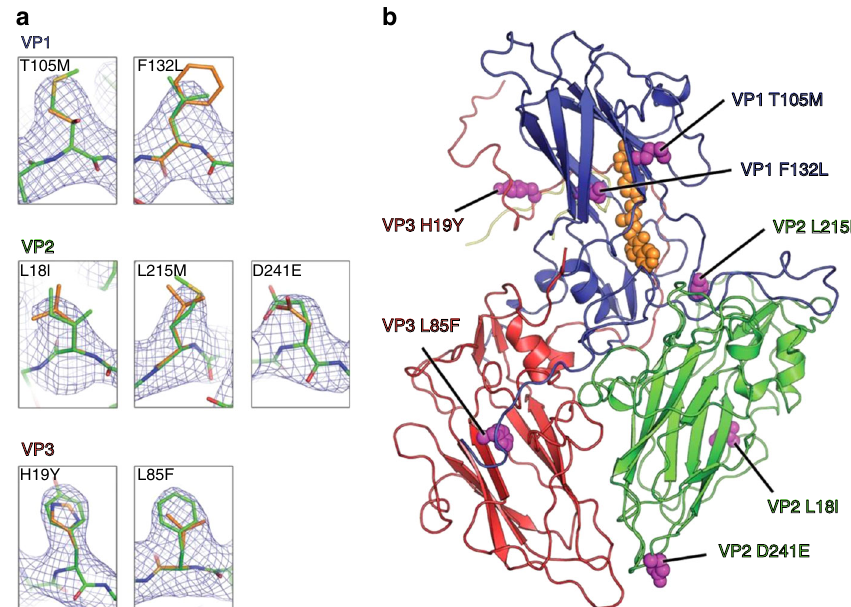
Fig. 4 Stabilizing mutations in PV3 sVLPs. a Mutations in the PV3 SktSC8 sVLP compared to wt sequence. Panels show a snapshot of cryo-EM density for each of the mutations present in the PV3 SktSC8 sVLP. Wt residues are shown as sticks colored orange , with mutated residues observed in the 3.6 Å cryo- EM map as green . Cryo-EM density maps are contoured at 1.0 σ . b Cartoon representation of the asymmetric unit for the PV3 SktSC8 sVLP. Individual subunits of the protomer are colored blue (VP1), green (VP2), red (VP3) and yellow (VP4). Mutations are shown as spheres and colored magenta . The position of the GPP3 molecule observed bound to the VP1 protein pocket of the 4.1 Å structure of PV3 SktSC8 sVLP is shown as orange